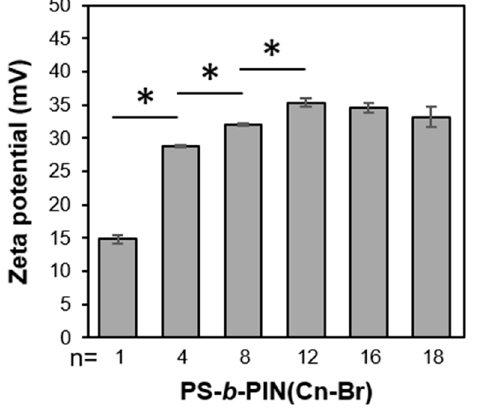
Figure 2. The zeta potential of PS- b -PIN with different side chain length. *: p <